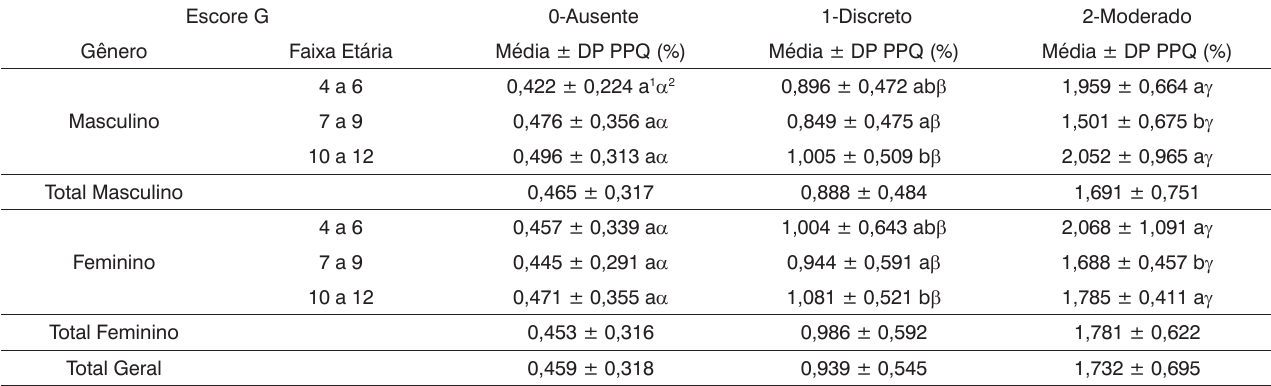
Tabela 8. Valores médios e desvio padrão (DP) de PPQ (%) e correlação com o escore do parâmetro G da escala GRBASI, o gênero e a faixa etária (em anos).